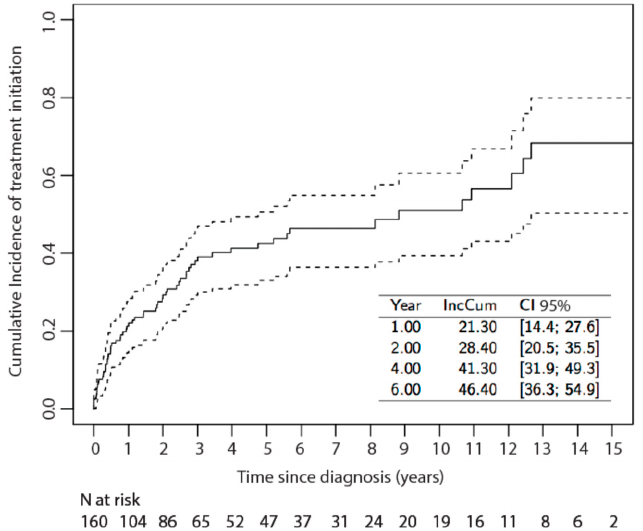
Figure 1. Cumulative Incidence of systemic treatment initiation in classic/endemic KS patients. Dashed lines correspond to the 95% Confidence Interval (CI). The inset table reports the cumulative incidences (IncCum) at 1, 2, 4 and 6 years after KS diagnosis, with their 95% CI.